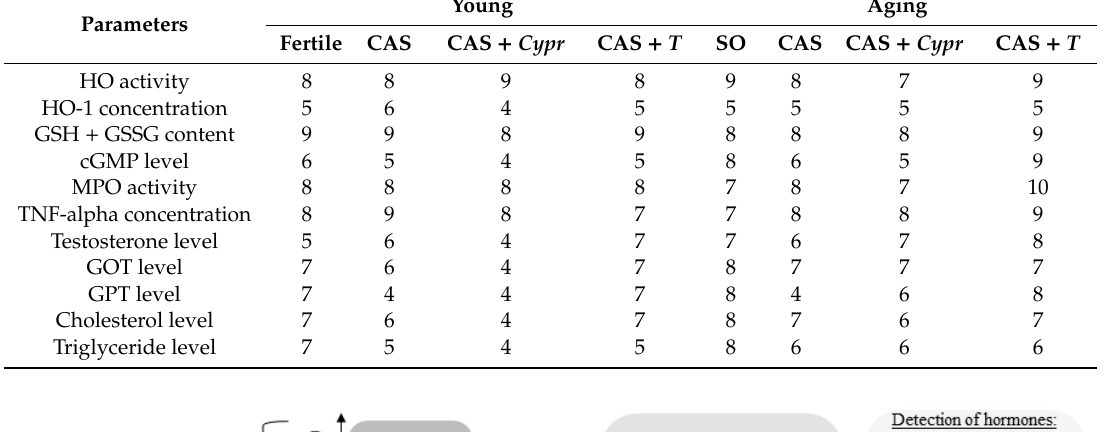
Parameters Table 1. Number of the animals per group (n). CAS = surgical castration, T = testosterone replacement therapy, Cypr = cyproterone acetate treatment, and SO = sham operation.